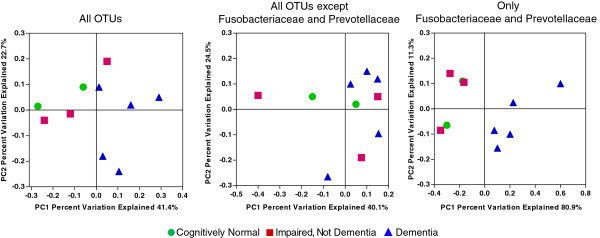
Clustering of bacterial taxa by cognitive function. Weighted UniFrac was used to generate a matrix of pairwise distances between communities and a scatterplot was generated from the matrix of distances using Principal Coordinate Analysis in QIIME. Each symbol represents the values of all samples from one participant analyzed collectively. In the left hand panel all OTUs that occur more than 150 times are included in the analysis. In the middle panel, the OTU table is further edited to remove any OTUs assigned to the Fusobacteriaceae or Prevotellaceae. In the right hand panel, only OTUs that were identified as Fusobacteriaceae or Prevotellaceae were analyzed. (green circle) cognitively normal, (red square) cognitively impaired without dementia, and (purple triangle) dementia. OTU, Operational Taxonomic Units.